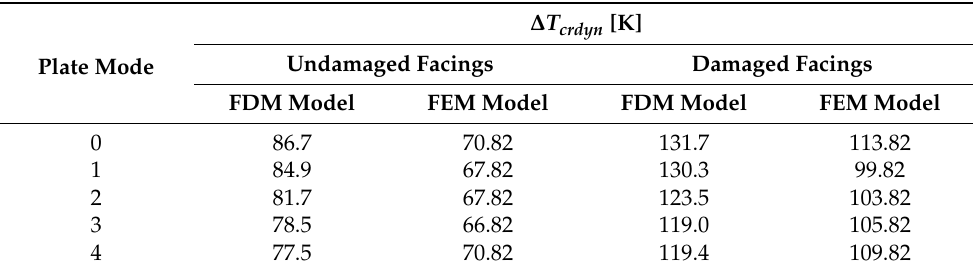
Table 5. Critical dynamic temperature differences of the FDM and FEM plate models with different modes loaded thermally with positive